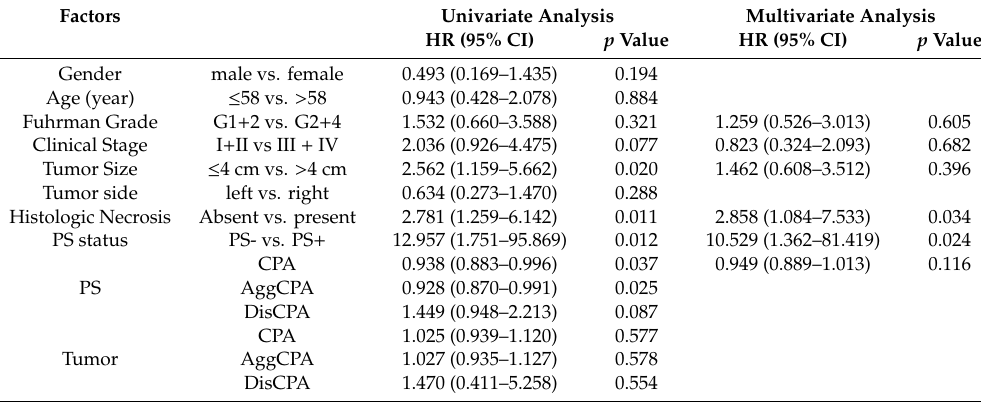
Table 3. COX regression analysis for progression free survival